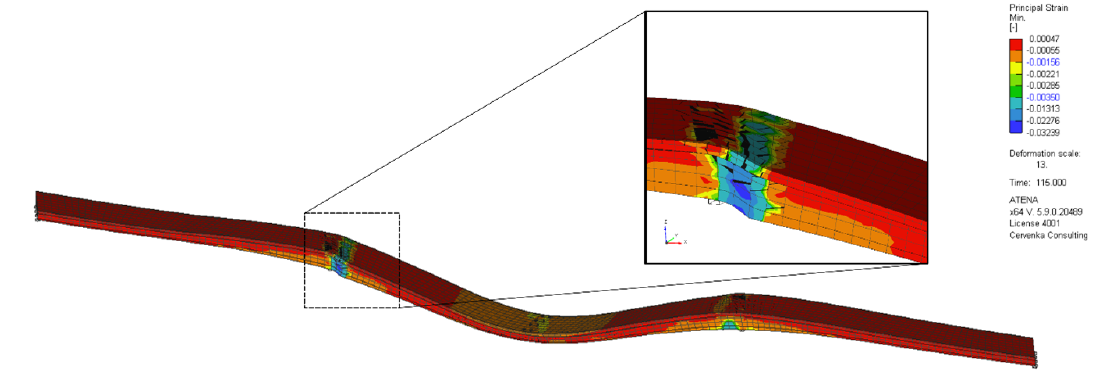
Figure 5. Deformed shape of the Wonka bridge after the peak load and the detail of the failure region near the left support.